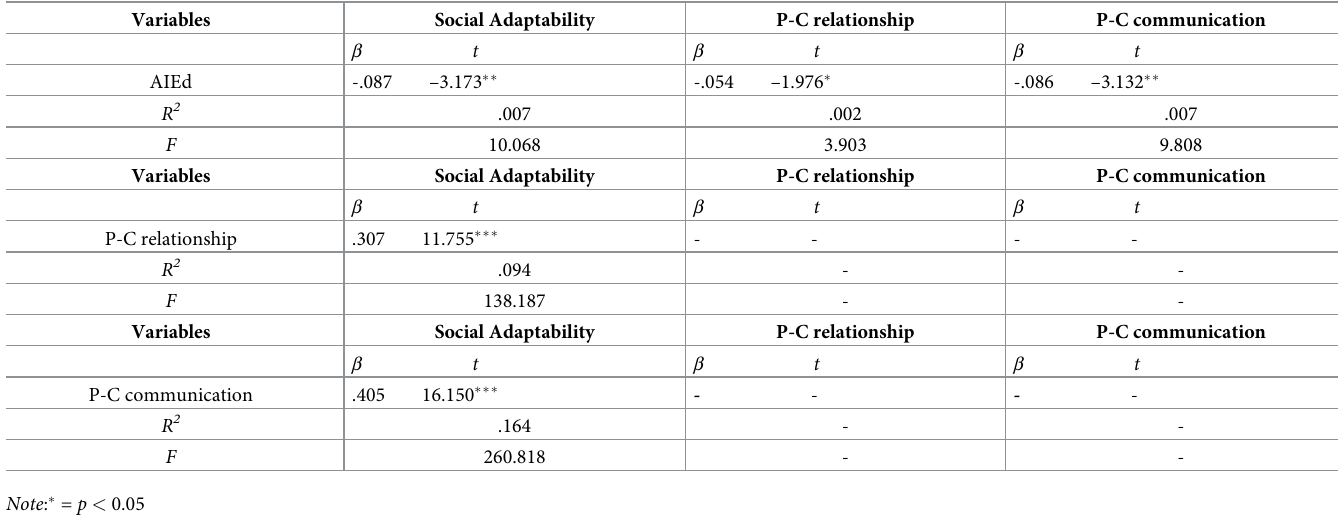
Table 3. Effect analysis of AIEd, social support and social adaptability.